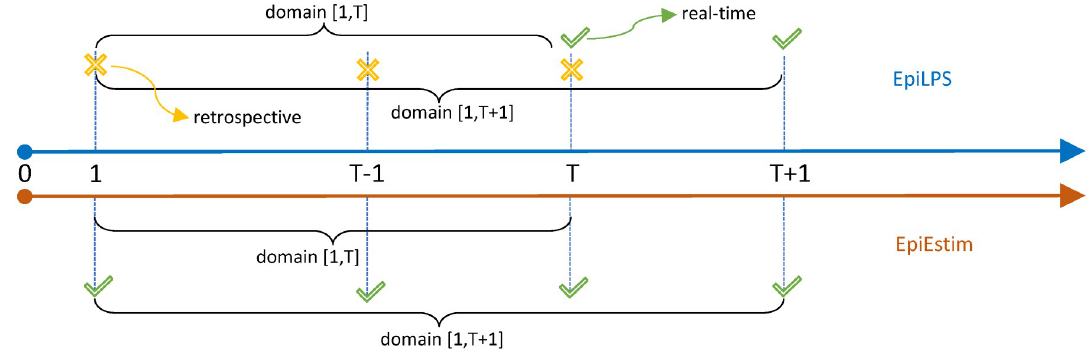
Fig 8. Real-time properties of EpiLPS (top) and EpiEstim (bottom) when applied on domains T ¼ ½ 1 ; T � and T � ¼ ½ 1 ; T þ 1 � . EpiLPS provides real-time estimates of R only at the boundary of the considered domain and estimates at preceding time points are t retrospective. On the contrary, estimates of R with EpiEstim are always real-time and therefore preferred for a timely usage. t